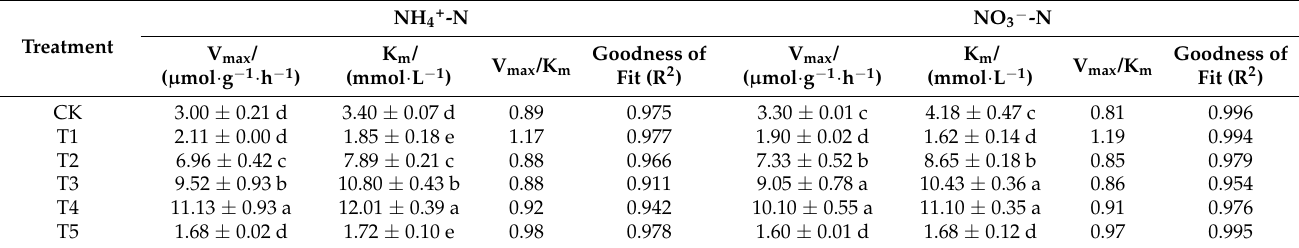
Table 1. N uptake kinetics of pecan roots under varying NH 4+ :NO 3 − ratios. Lowercase letters indicate significant differences between varying NH 4+ :NO 3 − ratios ( p <